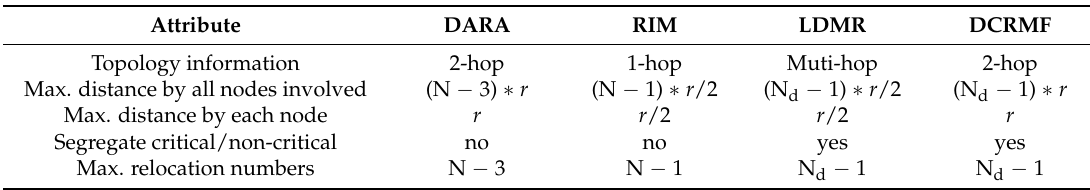
Table 2. Comparison of the Reactive